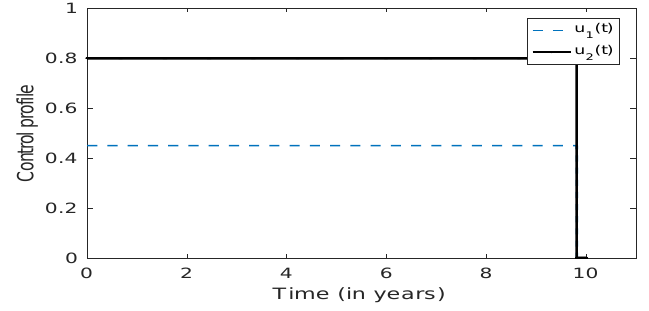
Figure 10. The control profile for Scenario